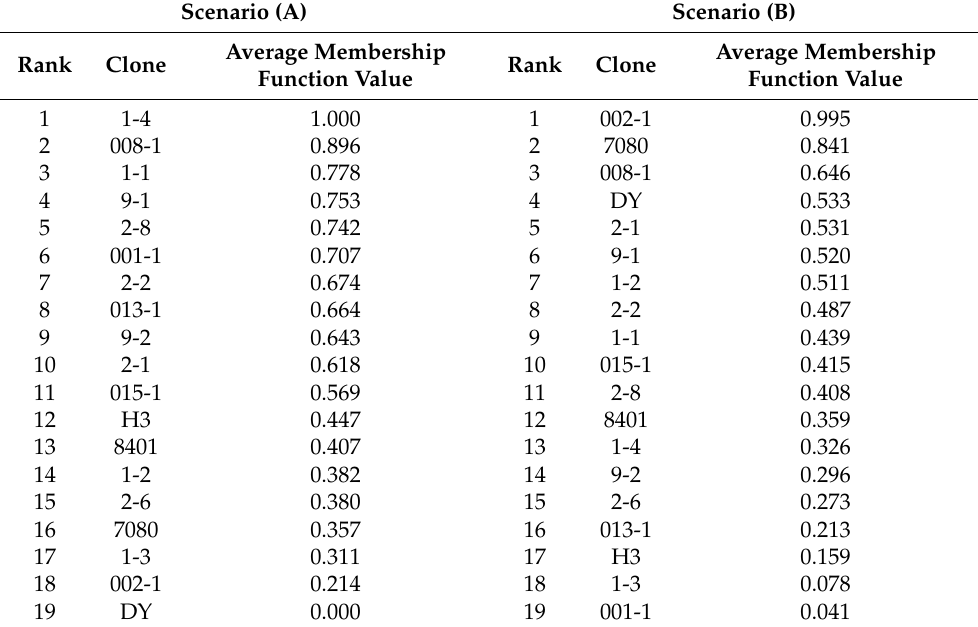
Table 5. Ranking of the membership functions for the clones under different selection scenarios. Scenario (A) Scenario (B) Average Membership Rank Clone Rank Function Value